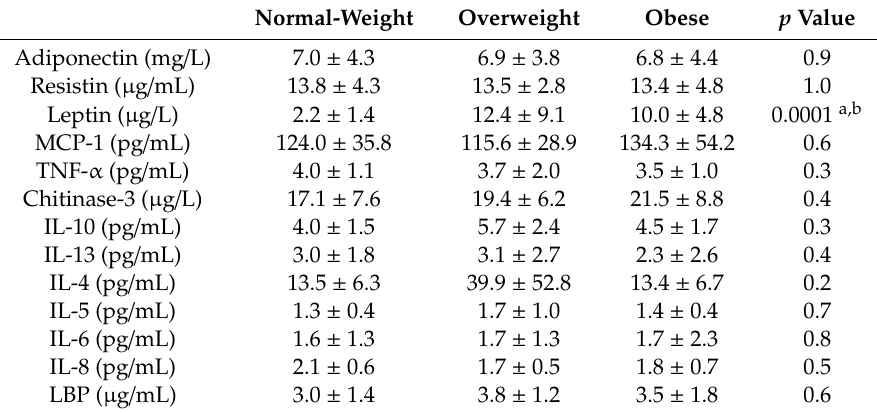
Table 2. Adipokines and inflammatory biomarkers in the BIOASMA cohort.